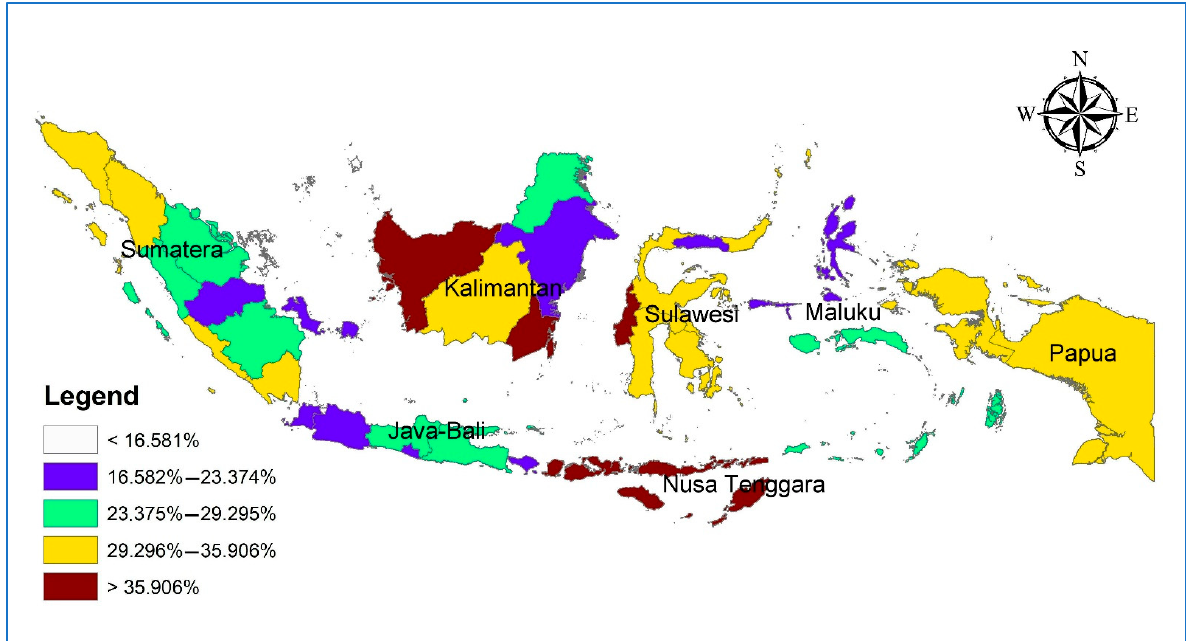
Figure 1. Distribution map of stunted toddlers with working mothers in Indonesia ( n = 44,071) .